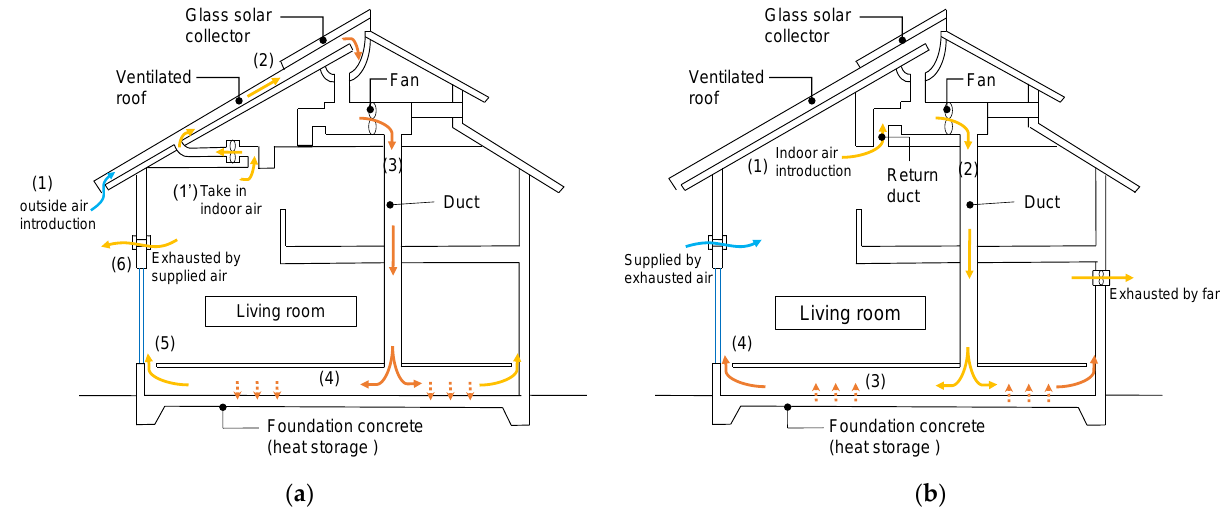
Figure 3. Air circulation route of Type A: ( a ) heat collection operation during daytime; ( b ) heat release during nighttime.